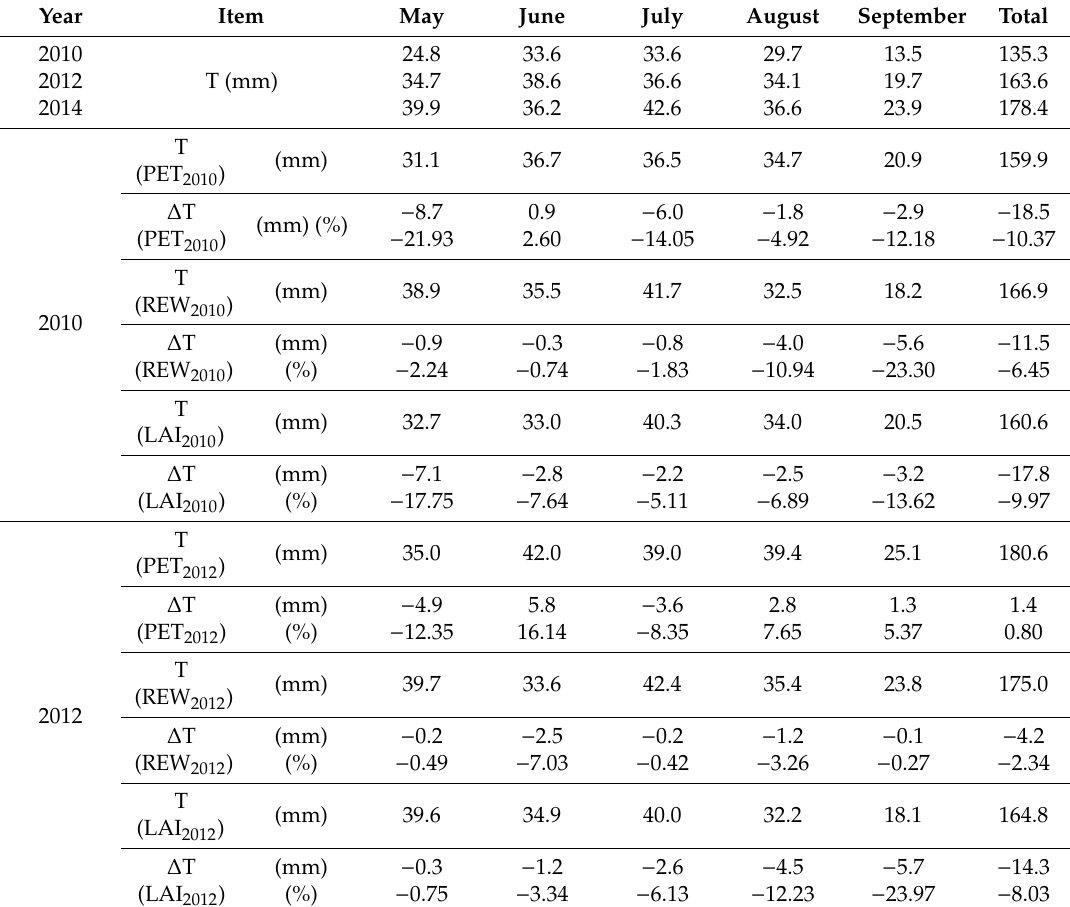
Table 5. The e ff ects of PET, REW, and LAI on the T in 2010 and 2012 compared with the baseline T in 2014 (positive / negative di ff erence viewed as promotion /